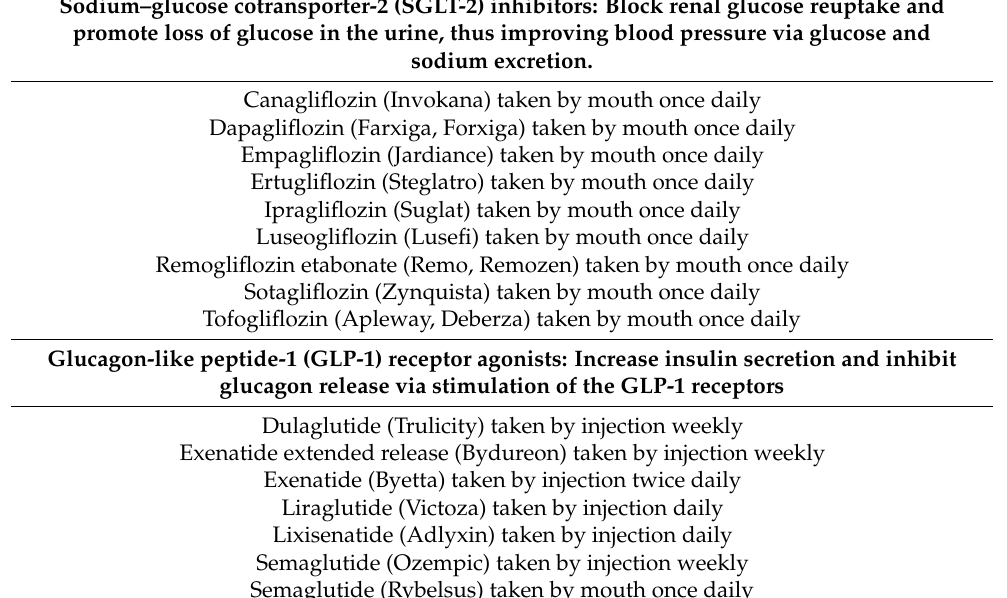
Table 1. The sodium–glucose cotransporter-2 (SGLT-2) inhibitors and glucagon-likepeptide-1 (GLP-1) receptor agonists in everyday